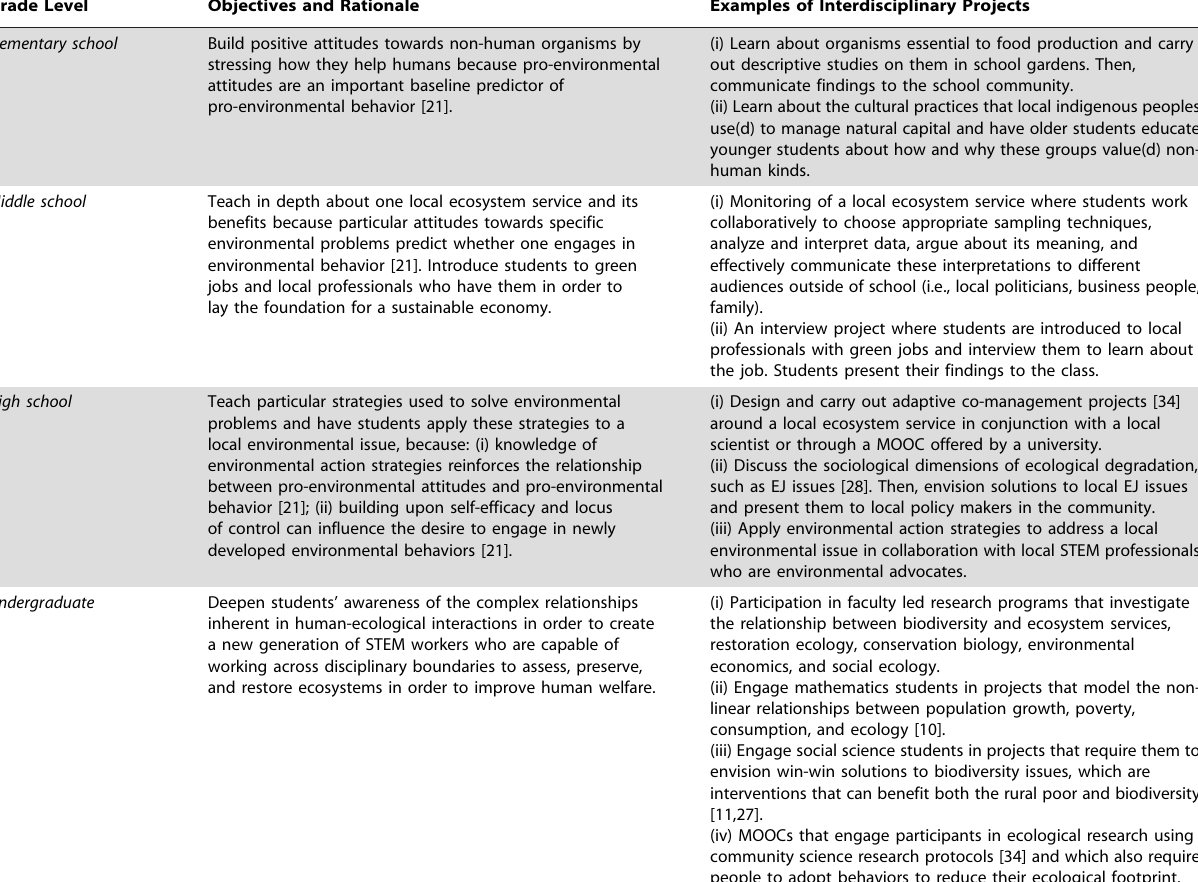
Table 1. Suggested objectives and projects for STEM education at each grade